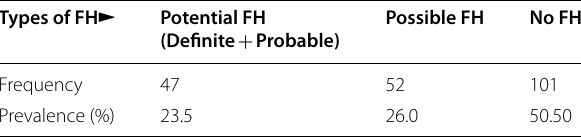
Table 2 Prevalence of potential, possible, and no FH Types of FH ►